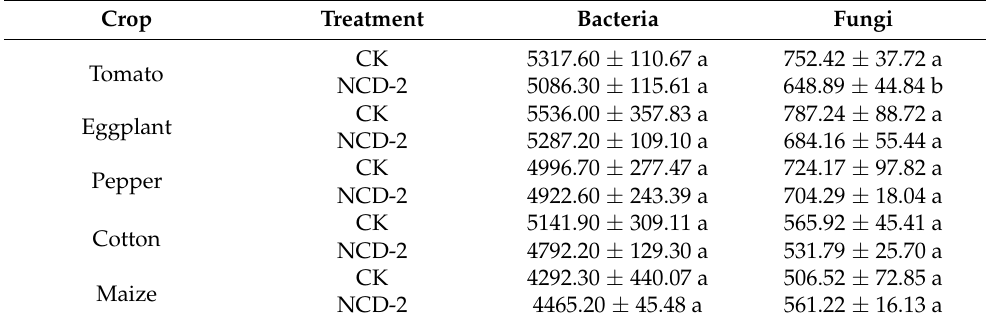
Table 1. ACE indices of bacteria and fungi in different crops after application of B. subtilis NCD-2.